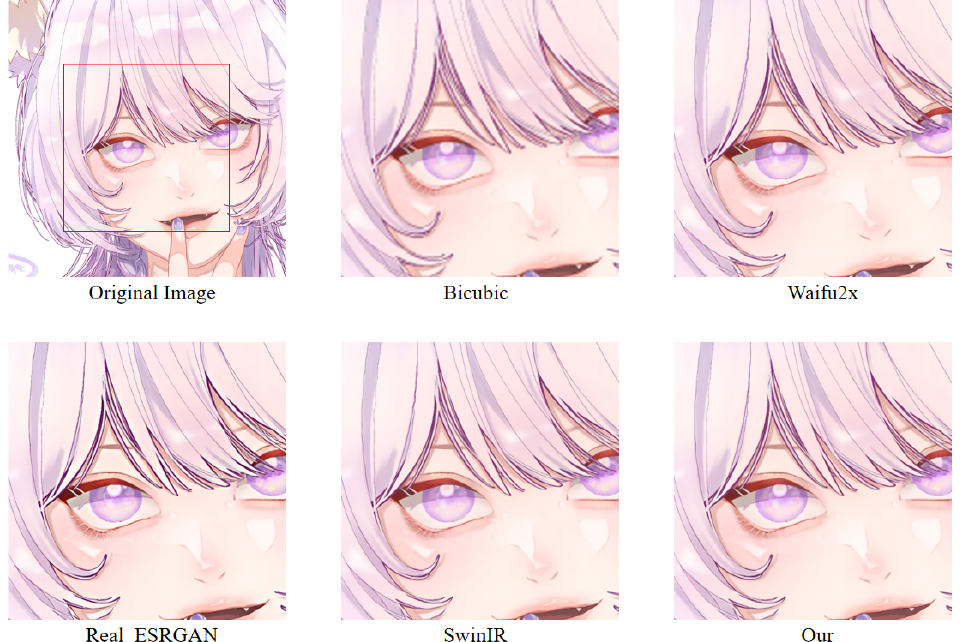
Figure 23. A result of an example image from the Animeface180 test dataset for different super- resolution methods. Facial detail comparison at 4 × super-resolution task.